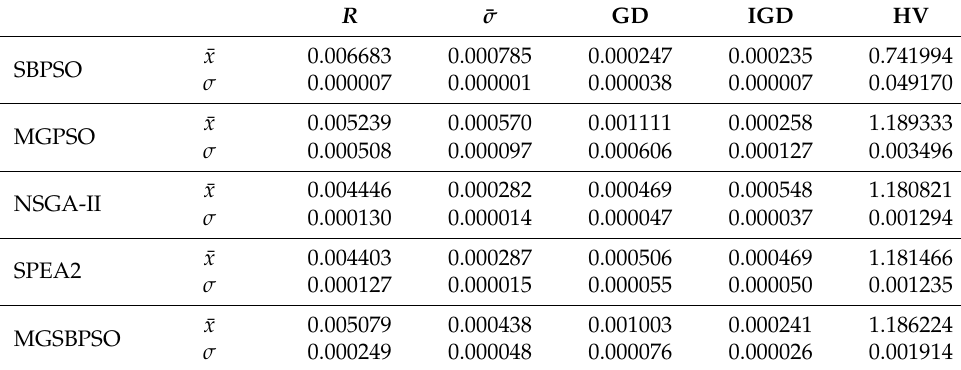
Table 9. FTSE 100 results for each performance